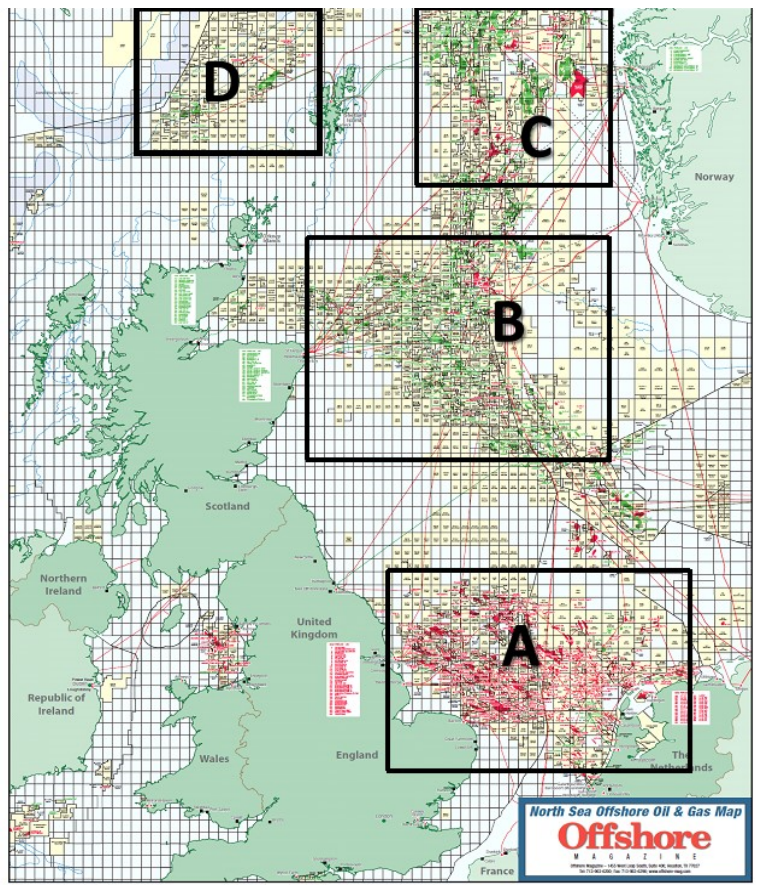
Figure 1. North Sea Offshore oil and gas map, 2013 [31]. Red and green areas depict gas and oil fields, respectively. Red and green lines depict gas and oil pipelines, respectively. Yellow blocks depict exploration licenses. Black boxes superimposed on the map depict the four sub-areas (A, B, C, D) considered in this study, as described in the text.